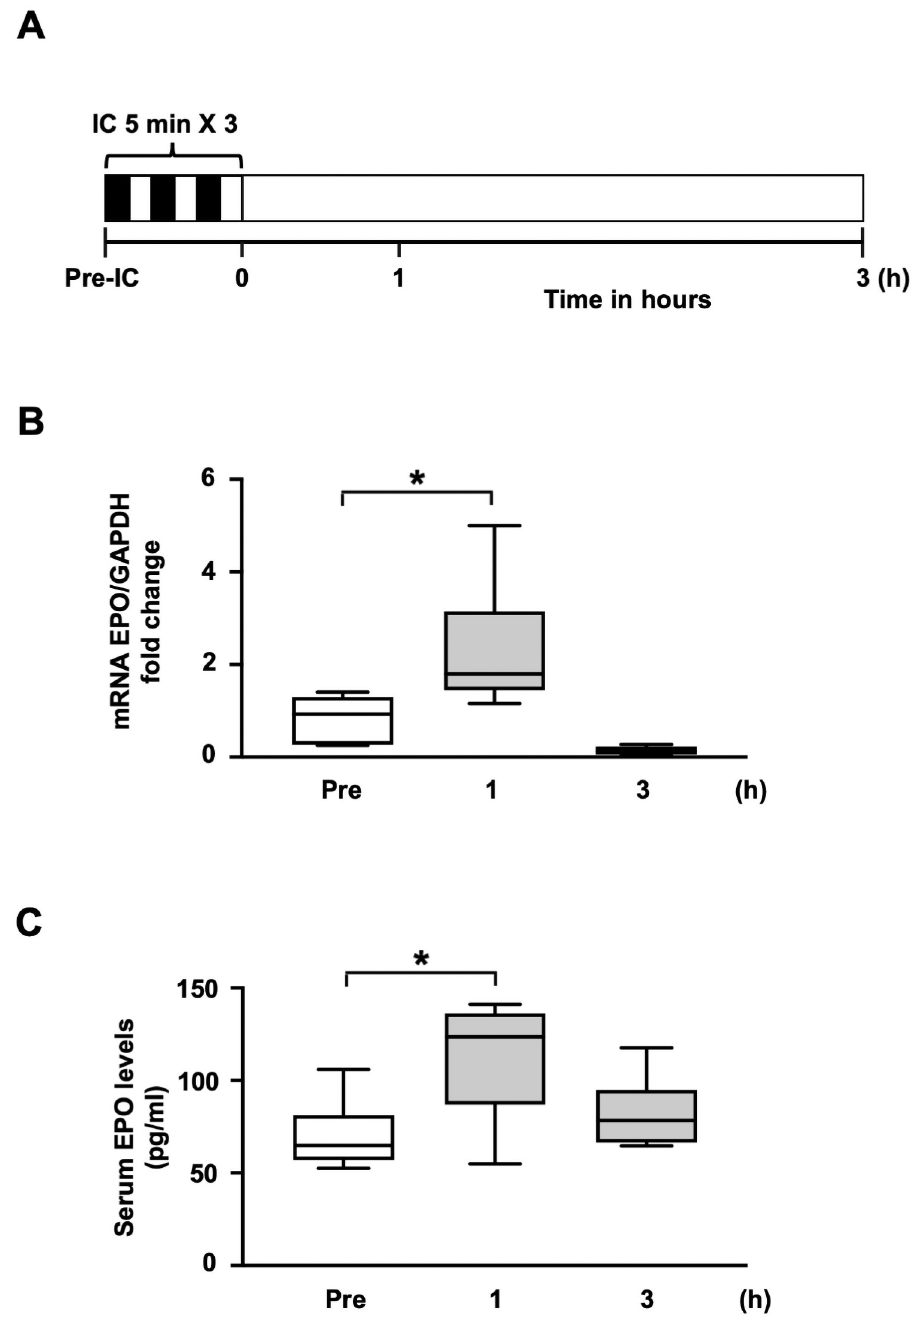
Fig 6. Rapid increase of circulating erythropoietin level after ischemic conditioning. ( A) Schematic illustration depicting the experimental protocol. IC was performed with three cycles of 5-min ischemia and 5-min reperfusion. Kidneys were collected at 1 h or 3 h after cardiac IC. Serum was collected at 1 h or 3 h after cardiac IC. ( B) EPO expression in the kidney after IC, analyzed by real-time PCR (n = 6–8 per group). Values are normalized to GAPDH, and expressed as a fold change from pre-IC values. � P < 0.05 (Dunn’s test). ( C) Serum levels of EPO in mice after IC at the indicated time-points, determined by an ELISA (n = 6–7 per group). � P < 0.05. (Dunn’s test). EPO, erythropoietin; IC, ischemic conditioning; PCR, polymerase chain reaction; ELISA, enzyme-linked immunosorbent assay; GAPDH, glyceraldehyde 3-phosphate dehydrogenase.